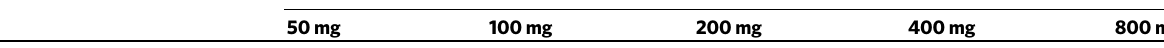
Table 2 Pharmacokinetic parameters Parameter